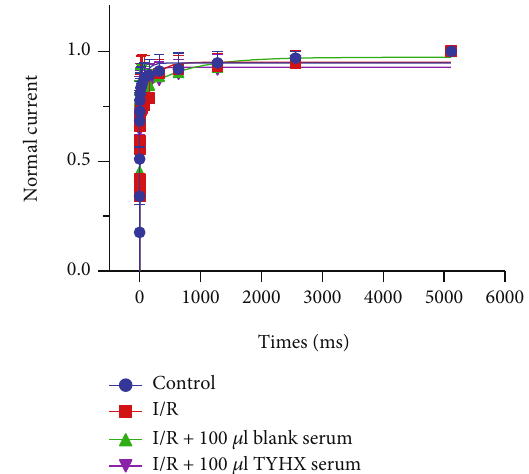
Figure 4: The e ff ect of TYHX on the recovery from the inactivation of I to